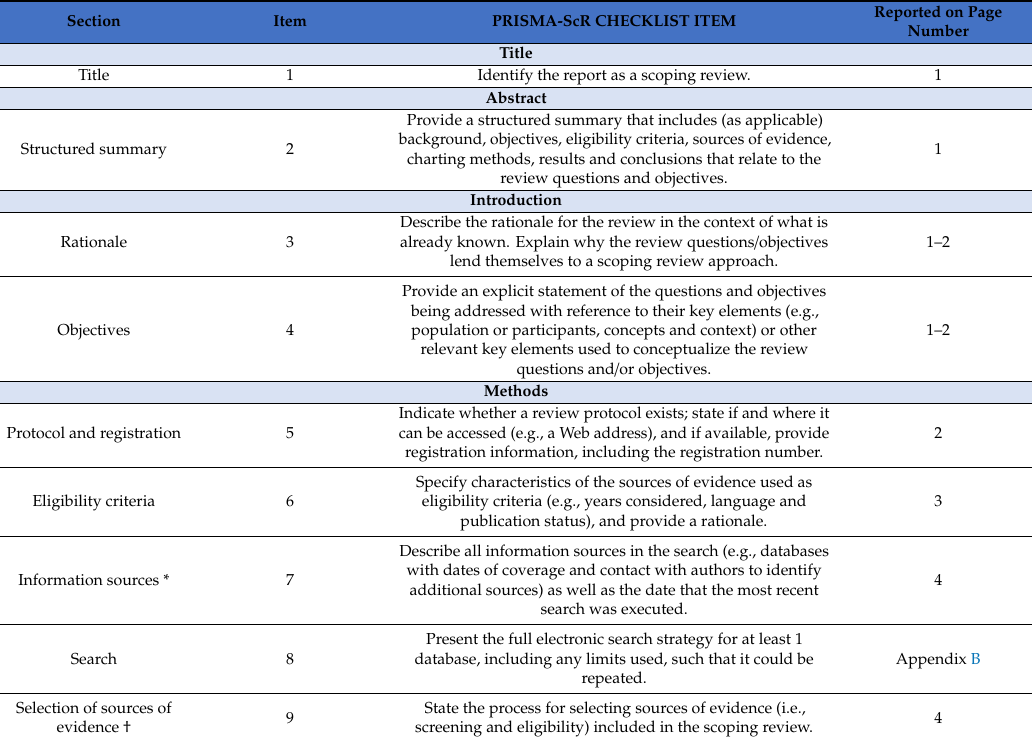
Table A1. Preferred Reporting Items for Systematic reviews and Meta-Analyses extension for Scoping Reviews (PRISMA-ScR) Checklist